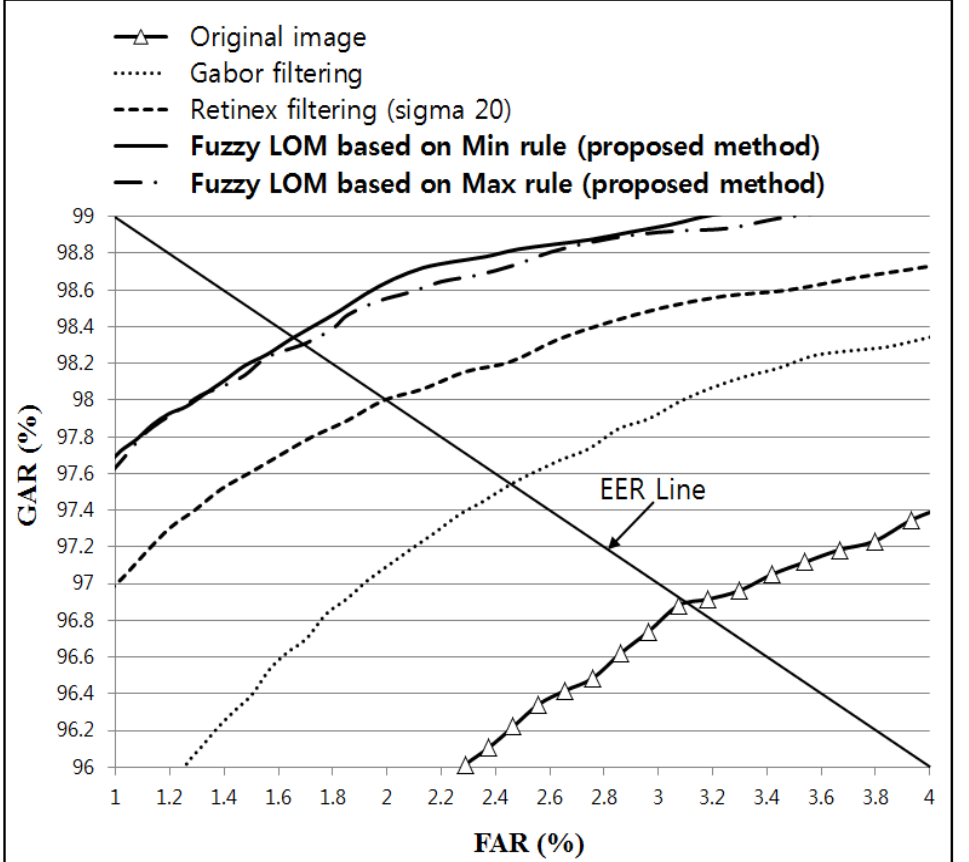
Figure 21. ROC curves obtained using the proposed method with Gabor filtering and Retinex filtering, with a sigma value of 20, and a LBP operator for images from database